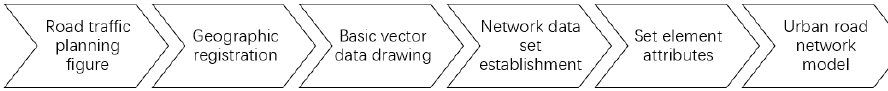
Figure 2. Planning road network.